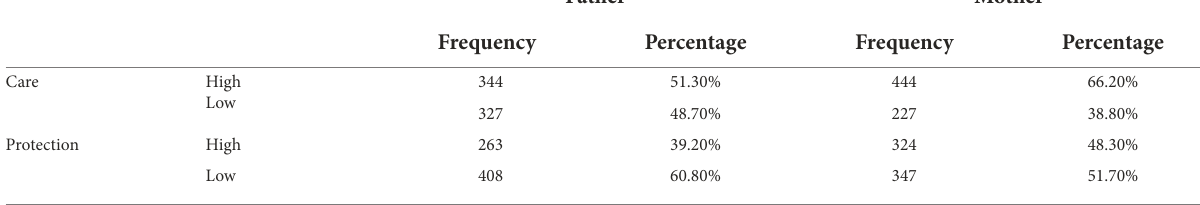
TABLE 1 Percentages concerning high or low “care” and “protection” of the parents in the